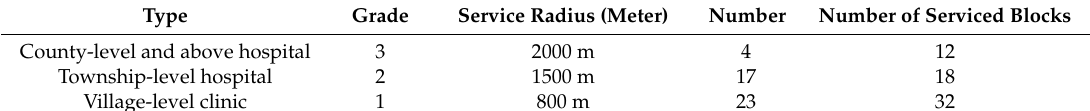
Table 4. Basic information on medical institutions at different levels Type